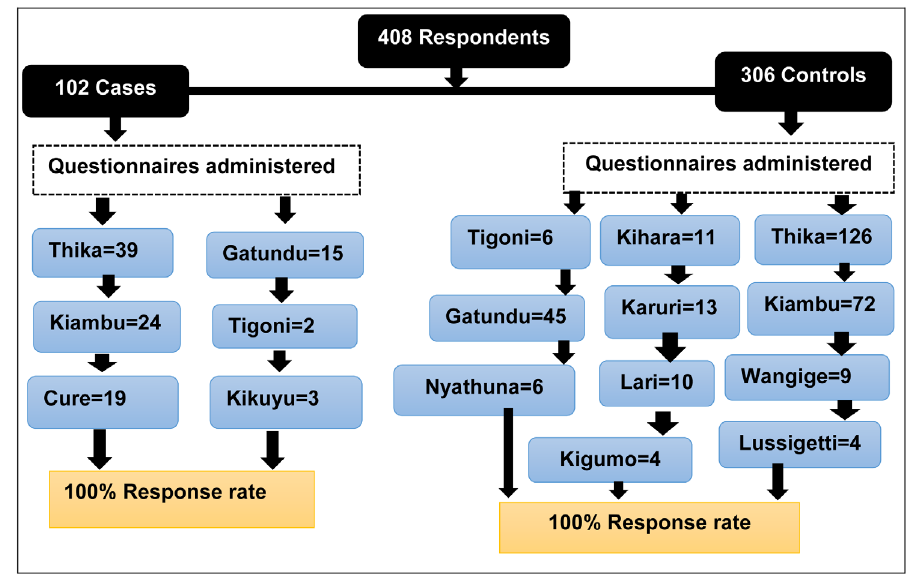
Figure 2. Flow chart of the systematic sampling strategy used in this